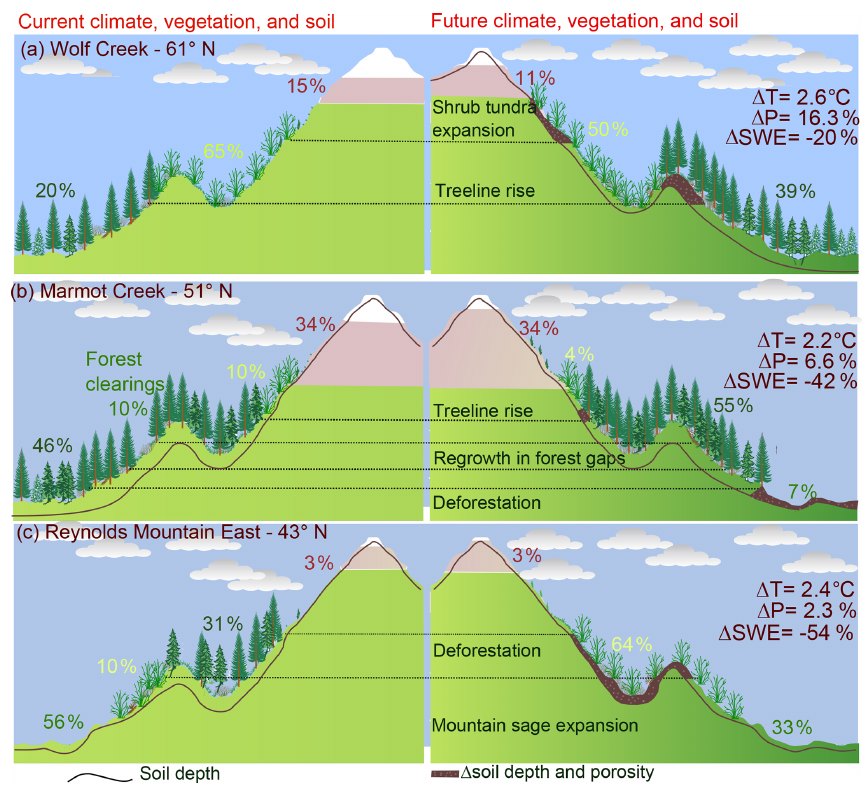
Figure 2. Schematic illustration of the vegetation cover under the base case and future climate, vegetation, and soil ( (cid:49)CV S ) in the Wolf Creek Research Basin, the Marmot Creek Research Basin, and Reynolds Mountain. Dark shading indicates areas where changes to the soil are expected in future. The numbers show the areal percentage of the alpine, forest, shrub tundra, grassland, and forest clearing biomes. (cid:49)T , (cid:49)P , and (cid:49) SWE are from Rasouli et al.